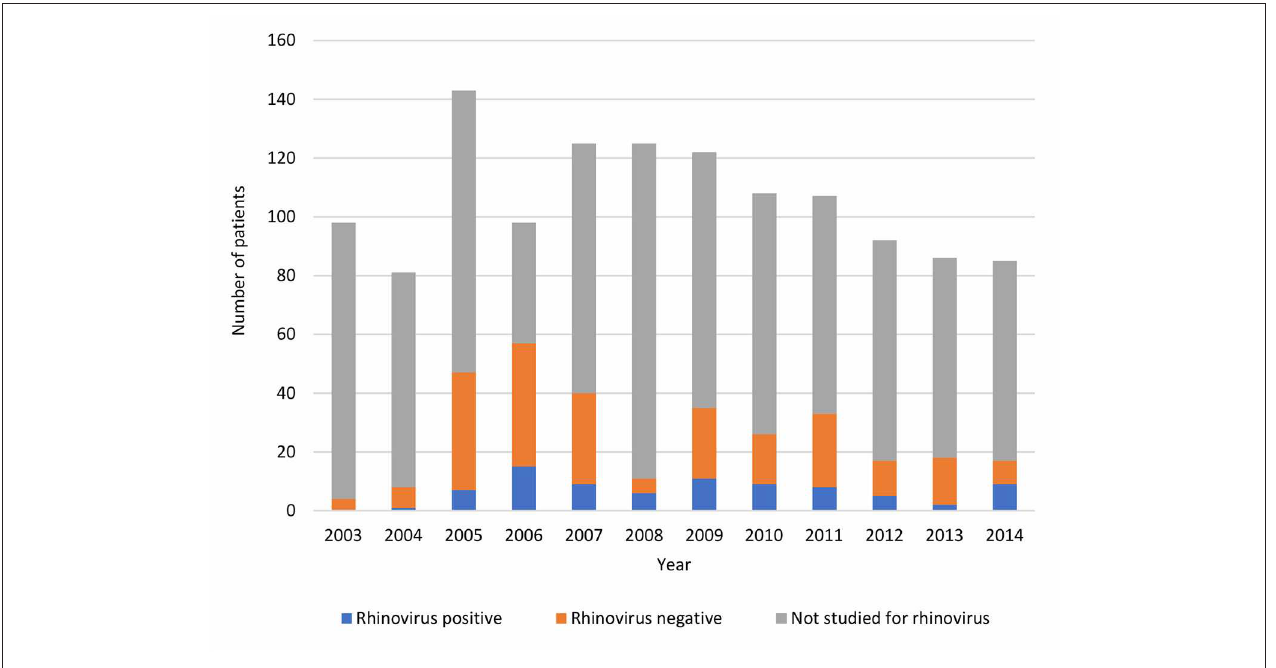
FIGURE 1 | Yearly numbers of pneumonia inpatients stratified by RV status during years 2003–2014.